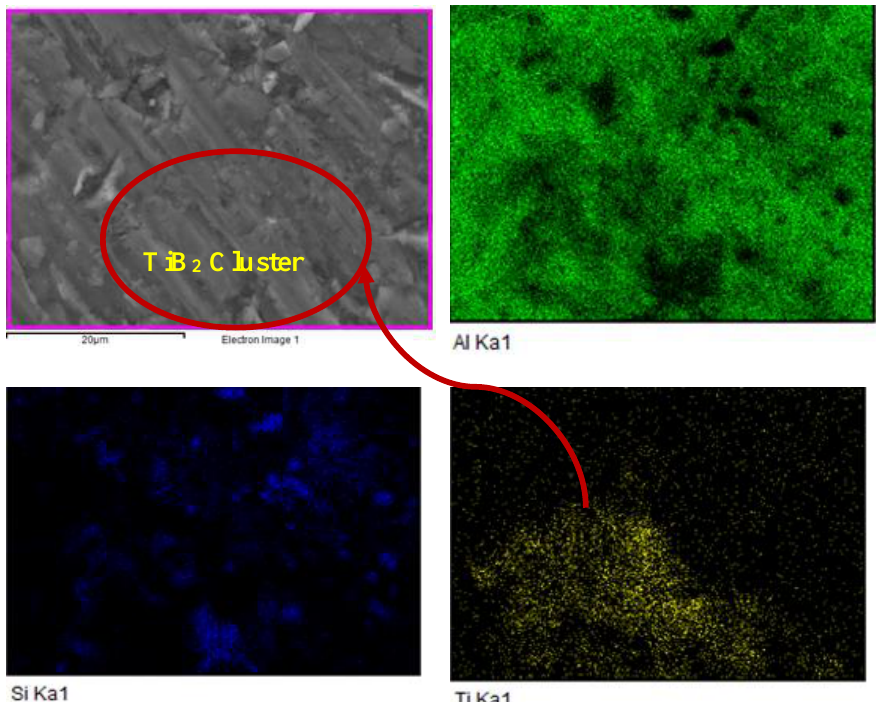
Fig. 5. FESEM-EDS image and its mapping of composites (Al-Si-Mg/TiB 2